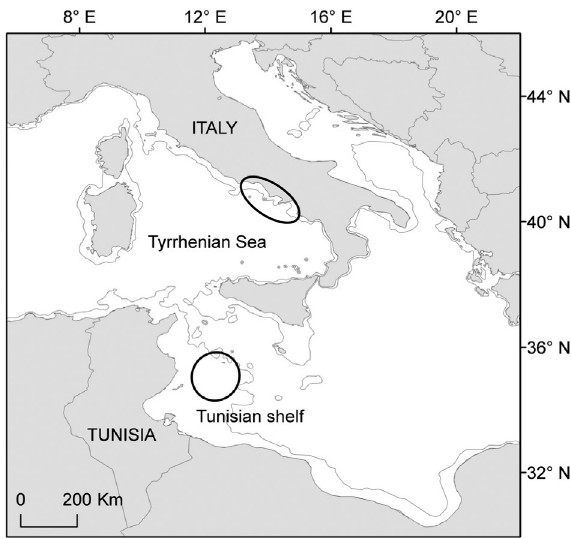
Fig. 1. – Central Mediterranean. The two neritic foraging areas where juvenile and adult loggerhead turtles were collected are ap- proximately shown by ellipses: the southeastern Tyrrhenian and the Tunisian shelf. The 200-m isobath, conventionally indicating the continental shelf, is also